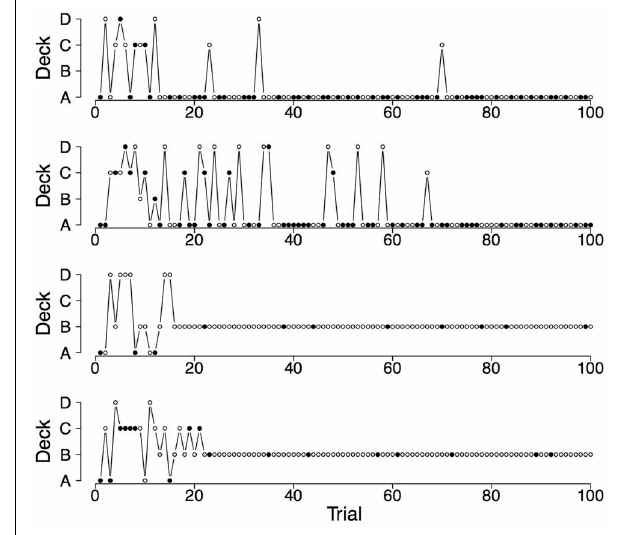
FIGURE 4 | Deck selection profiles of four healthy participants showing a pronounced preference for the bad decks.